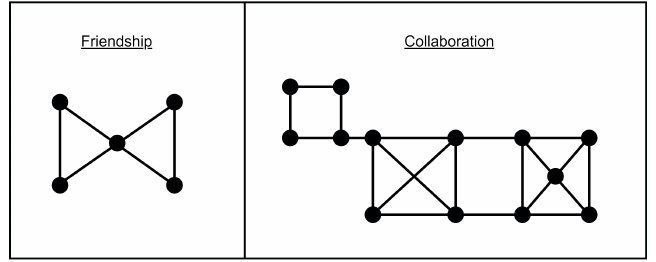
Figure 2. Pre-intervention